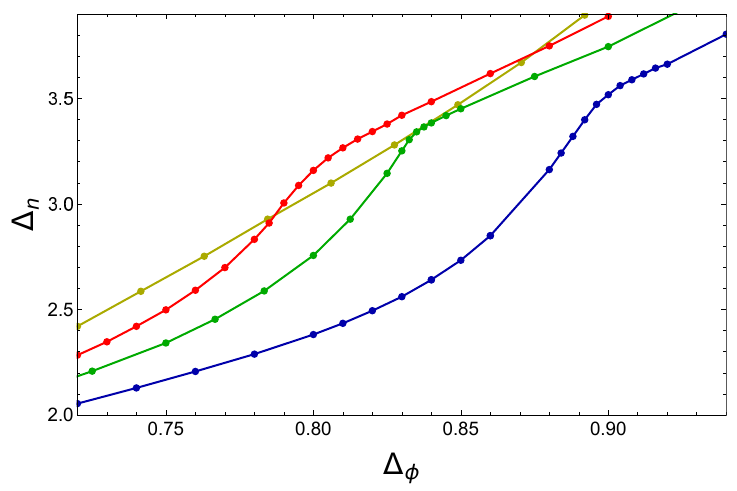
Figure 4 . Numerical bootstrap bound on the scaling dimension of the first n-channel scalar operator in CFTs with S N Z 2 symmetry (large ∆ φ region). Yellow, red, green and blue curves are for ⊗ N = 4 , 6 , 10 , 100 respectively. The curves are obtained at Λ = 23.